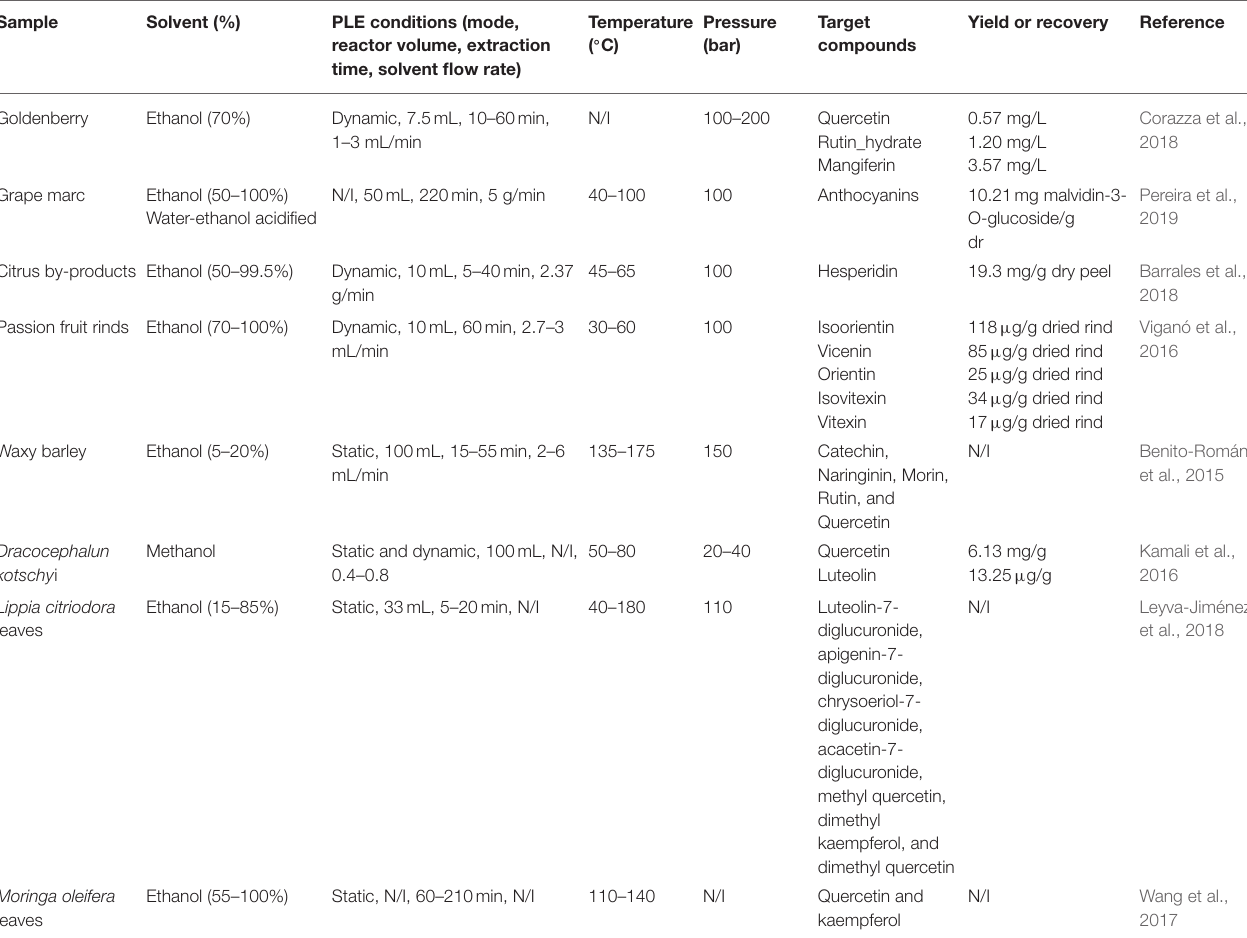
TABLE 4 | Survey on the applications of PLE to obtain flavonoids from natural sources using environmentally-friendly organic solvents.